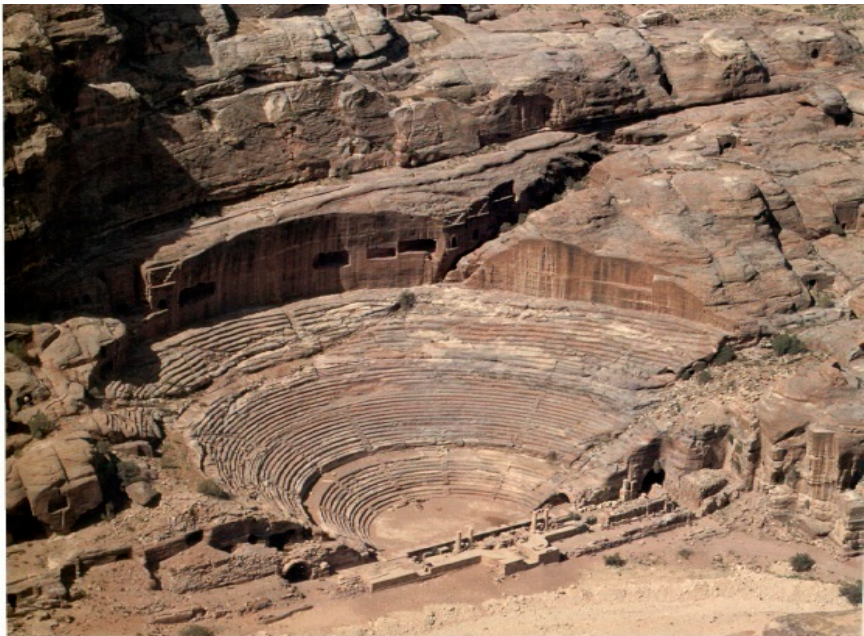
Figure 17. Theater with a seating capacity of 5000 to 6000 persons. Frontal pipelines extend to elevated basins above the south bank marketplace area to support fountains with (a probable) pipeline extension to areas above the Great Temple.